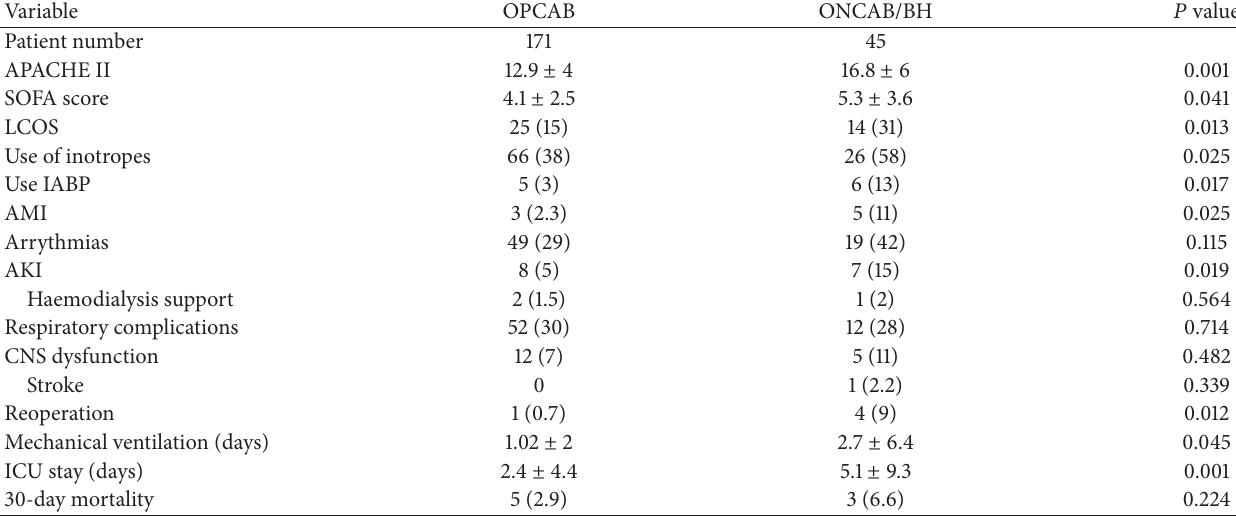
Table 2: Postoperative risk factors, morbidity, and mortality.